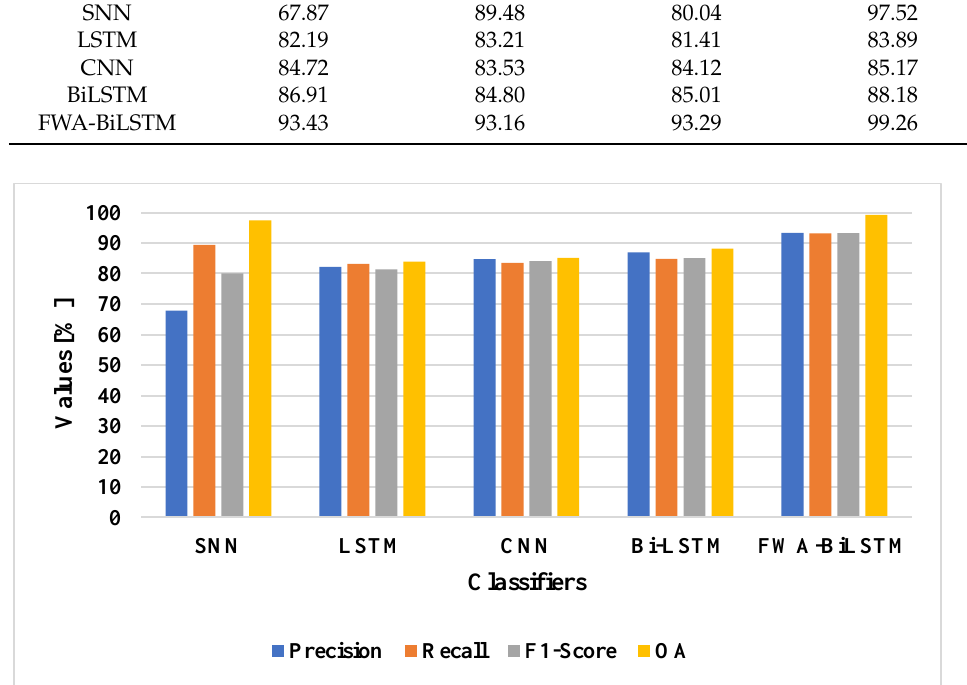
Figure 6. Classifier comparison of FWA-BiLSTM model on LEVIR-CD dataset.